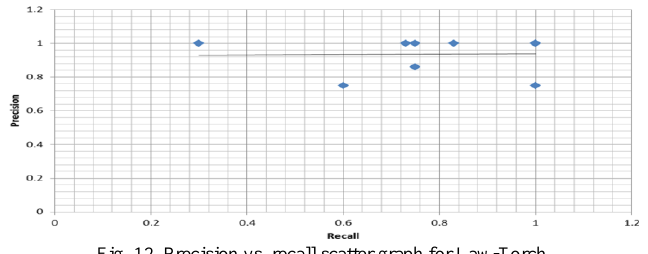
Fig. 12. Precision vs. recall scatter graph for Law-Torch.